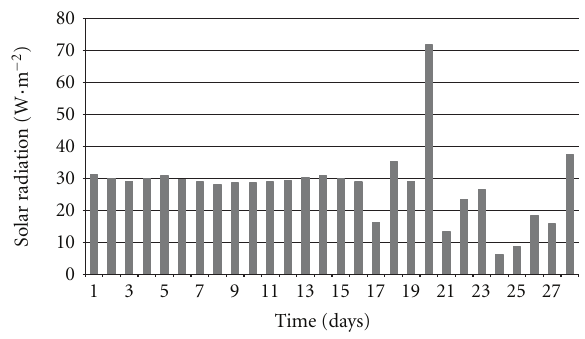
Figure 8: The course of insolation during the winter cycle (Decem- ber).